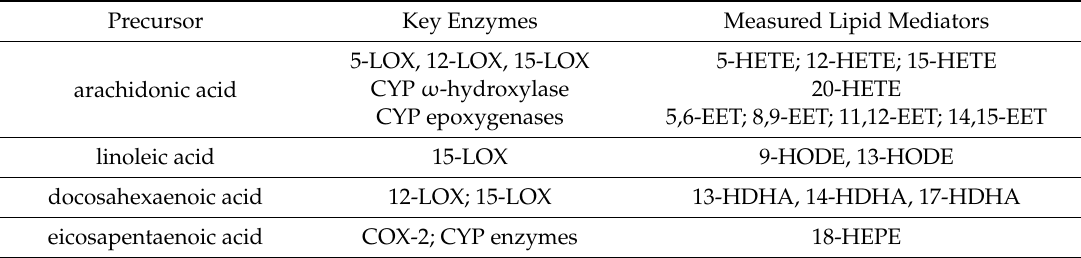
Table 1. Overview of measured lipid mediators with precursor and involved major enzymes.